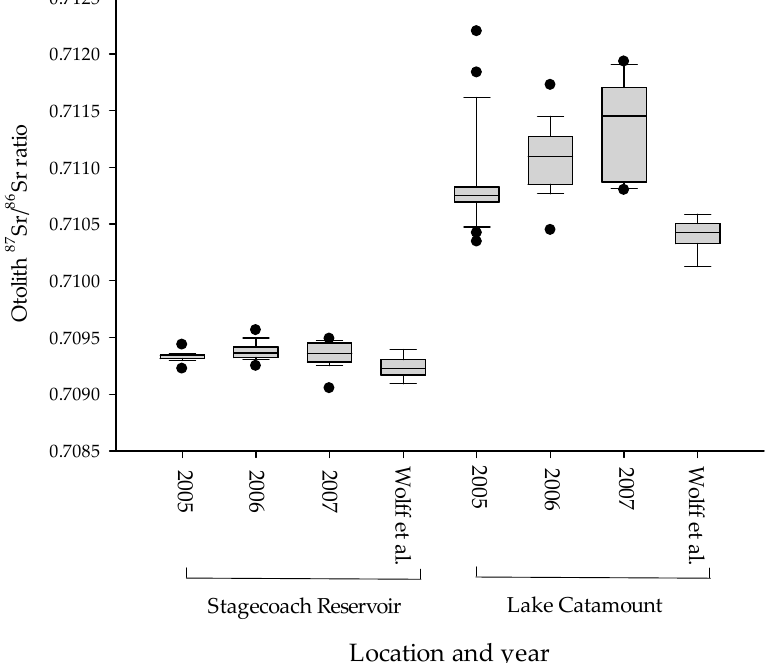
Figure 4. Box plots of the 87 Sr/ 86 Sr ratio from northern pike otoliths collected from Lake Catamount and Stagecoach Reservoir, Colorado, USA from 2005–2007. Wolff et al.’s [34] data were collected as part of a broader spatial scale studyand included multiple age classes of fish.